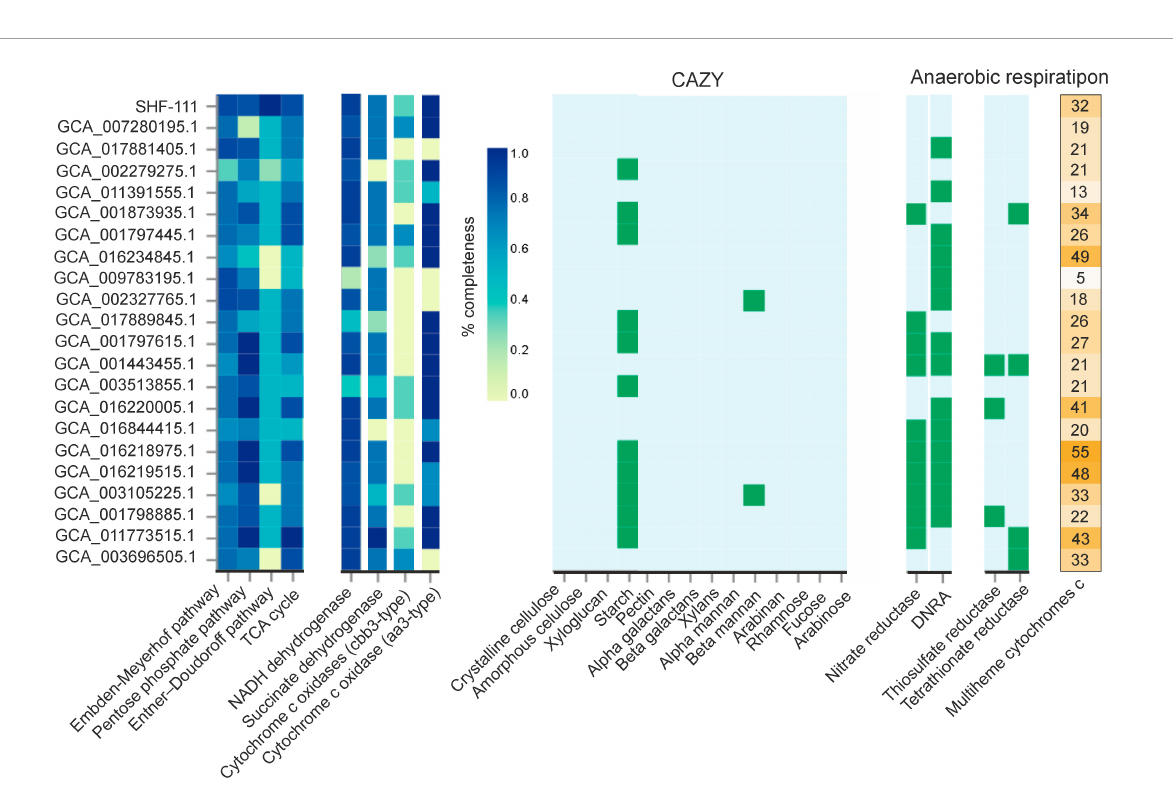
FIGURE5 Comparative analysis of the main metabolic pathways along the candidate phylum MBNT15. The completeness of the metabolic pathways and the completion of the subunits of the respiratory complexes were assessed using DRAM. The presence/absence of carbohydrate-active enzymes and enzymes involved in dissimilatory reduction of nitrogen and sulfur compounds was also detected using DRAM. The rightmost column shows the number of multiheme cytochromes c present in the genomes. DNRA, ammonia-forming cytochrome c nitrite